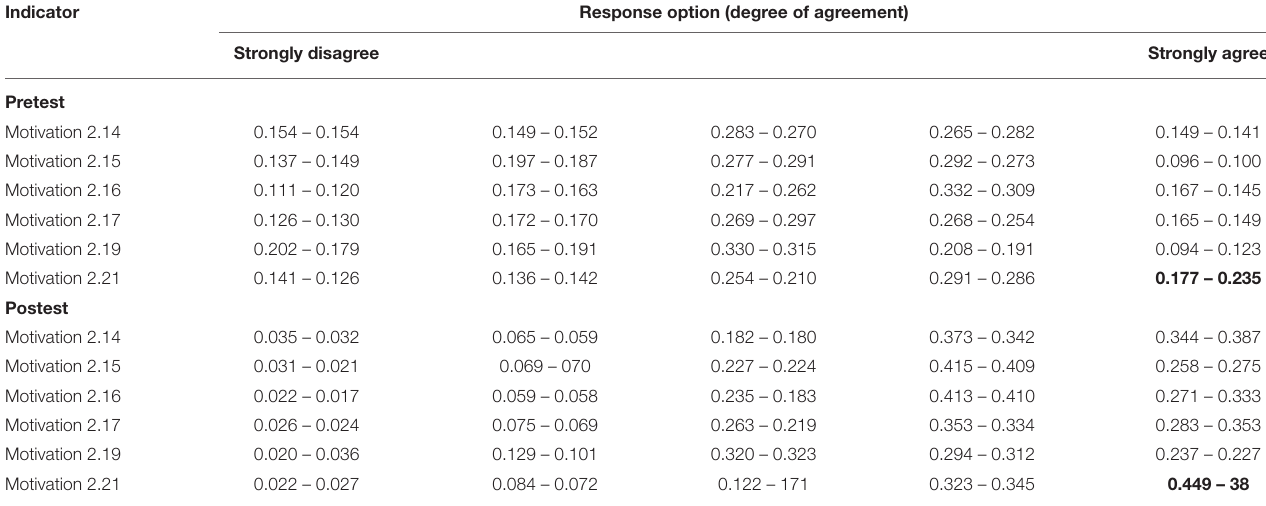
TABLE 4 | Estimated probabilities for the metric invariance models (scale invariance—loading invariance model) and strong invariance (threshold invariance).